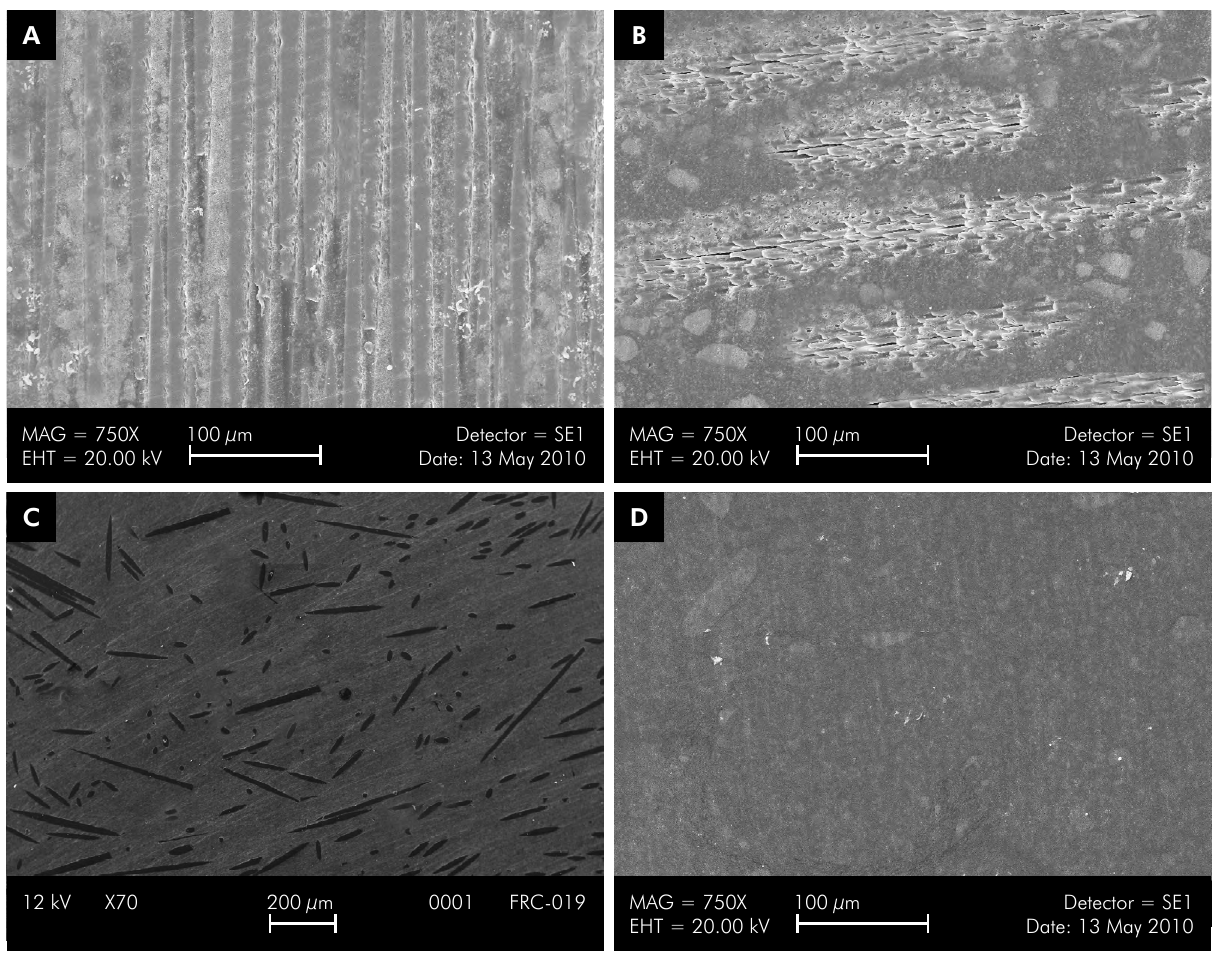
Figure. A. Scanning electron microscopic image of EUFRC, 750× magnification; B. Scanning electron microscopic image of EBFRC, 750× magnification; C. Scanning electron microscopic image of ERFRC, 750× magnification; D. Scanning electron microscopic image of EC, 750×